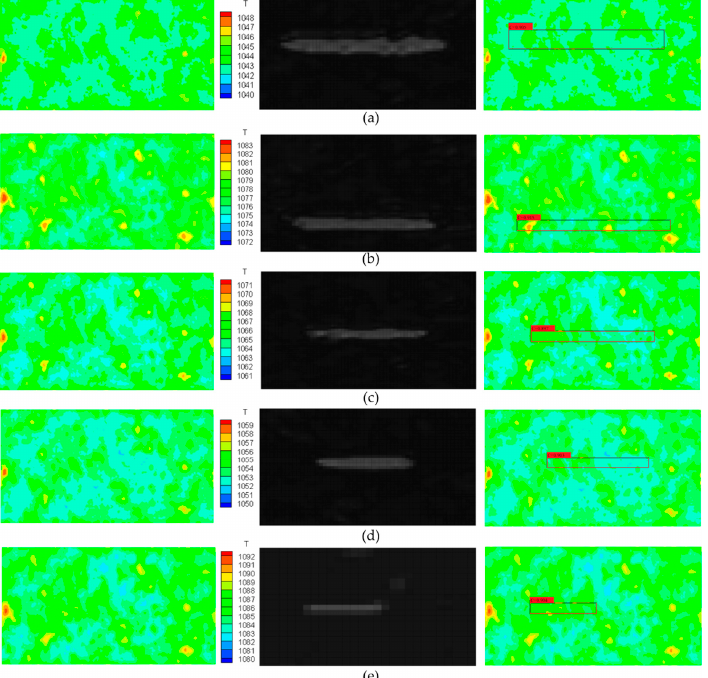
Figure 3. Examples of large scale crack detection results of using MSE-Faster R-CNN. ( a ) Porosity = 5%, Crack length = 260 μ m; ( b ) Porosity = 20%, Crack length = 220 μ m; ( c ) Porosity = 15%, Crack length =180 μ m; ( d ) Porosity = 10%, Crack length = 140 μ m; ( e ) Porosity = 25%, Crack length = 100 μ m.